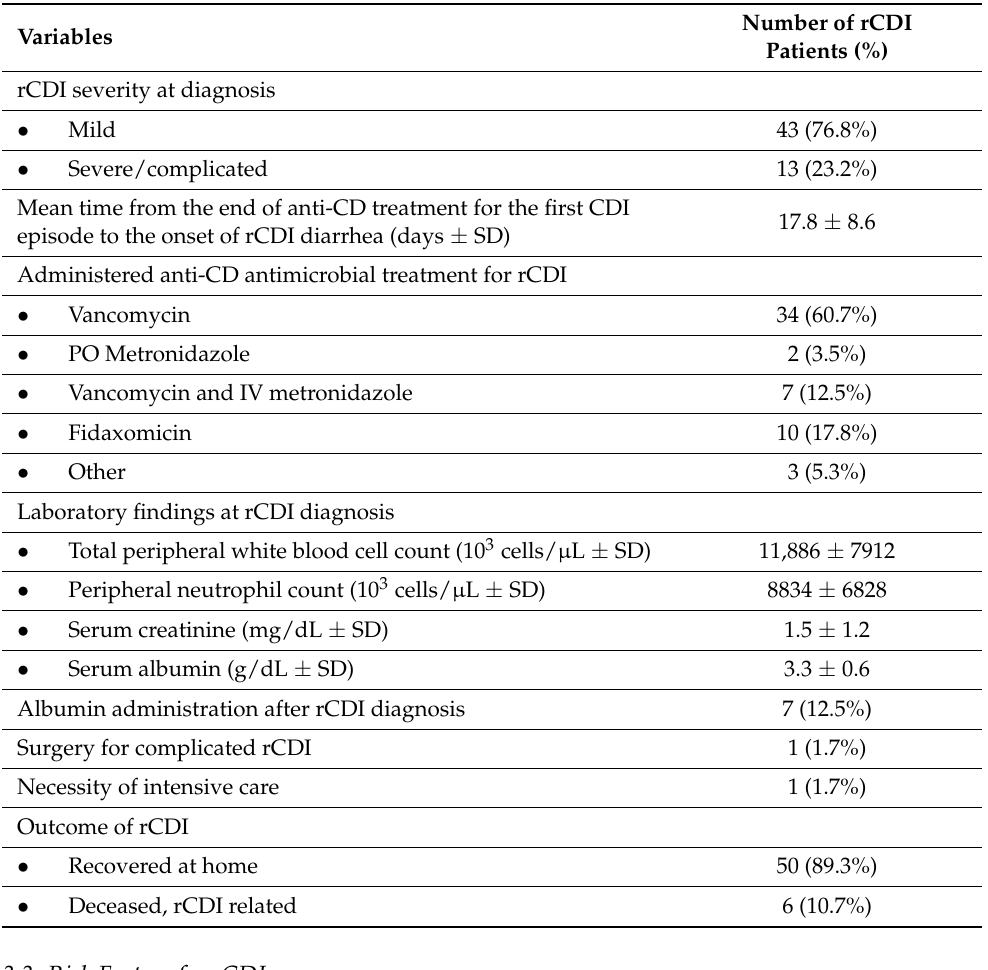
Table 3. Outcomes and characteristics of the 56 rCDI patients. SD: standard deviation. rCDI: recurrent Clostridioides difficile infection. PO: per os. IV: intravenous administration.